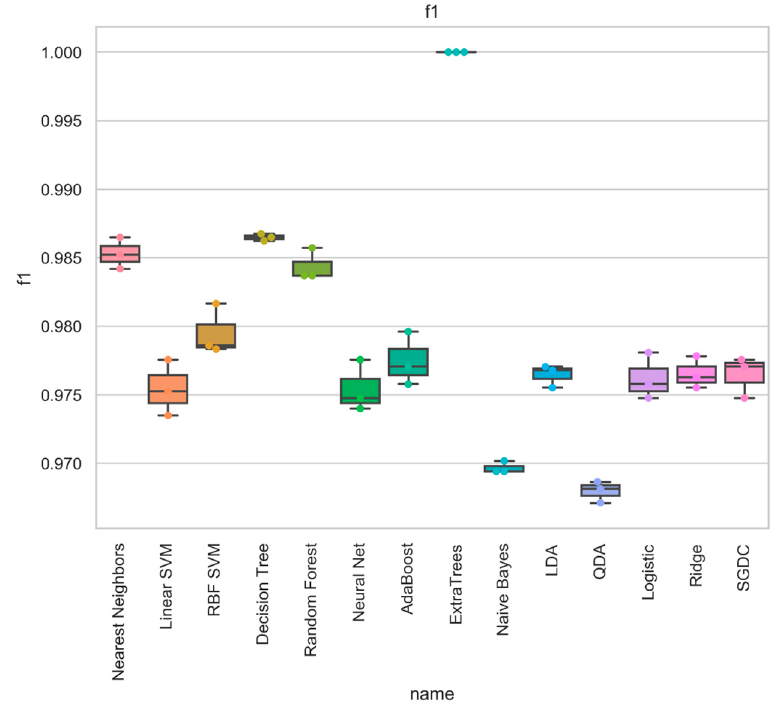
Figure 7. Comparison of performance of ensemble model by final-stage classifier: F1-score.